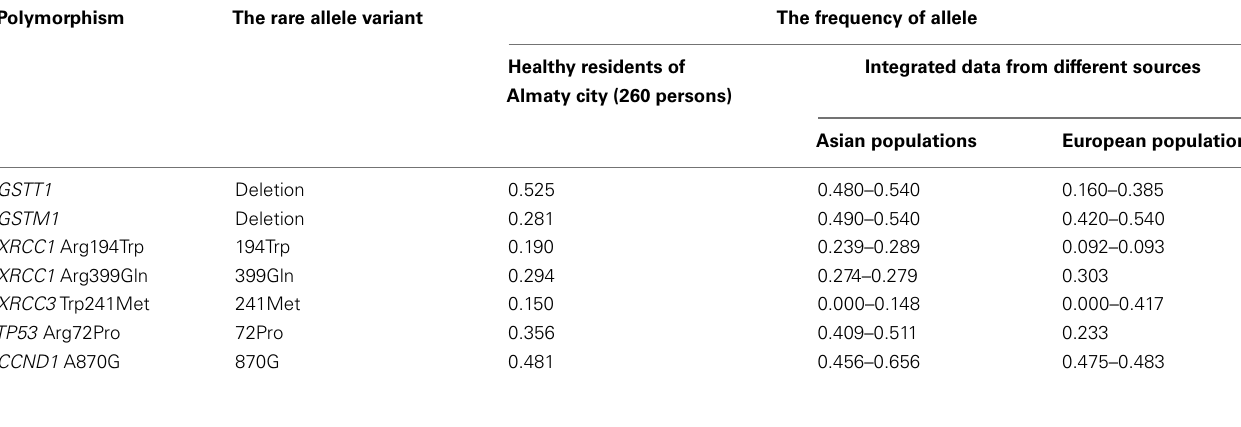
Table 8 |The comparison of rare allele frequencies of healthy inhabitants ofAlmaty city with earlier studied populations.